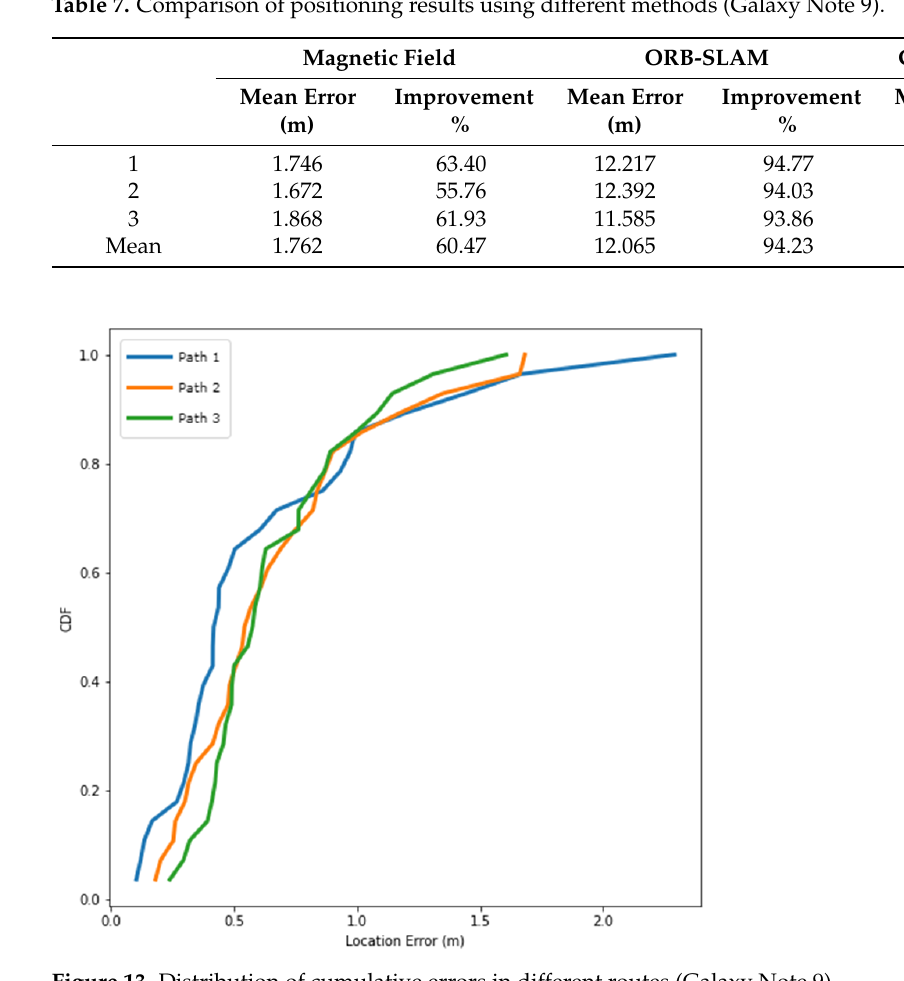
Figure 13. Distribution of cumulative errors in different routes (Galaxy Note 9).